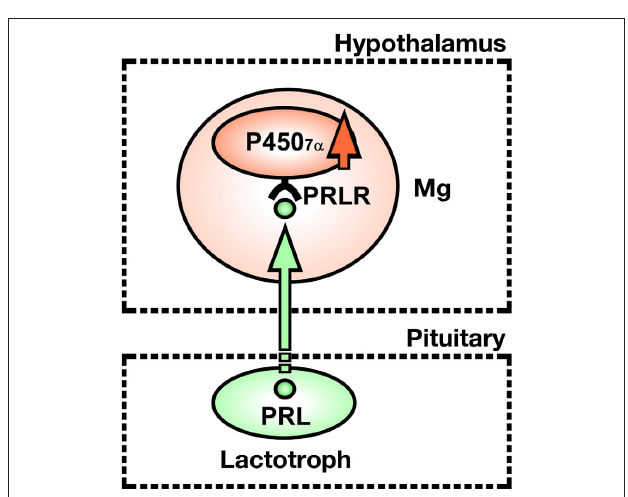
FigurE 9 | Schematic model depicting the possible action of PrL on the expression of